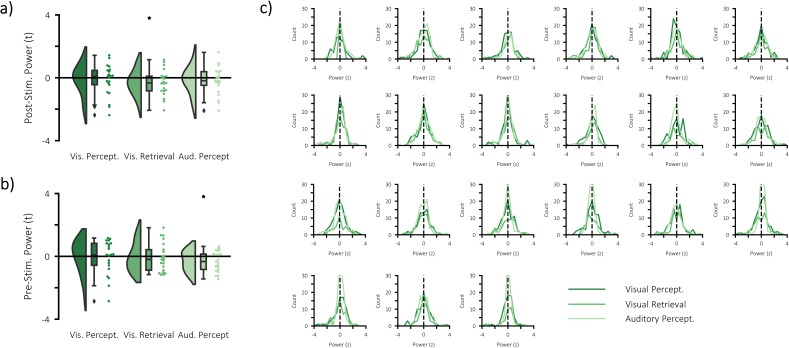
Investigating bimodal alpha power and stimulus-specific information.(a) Raincloud plot displaying the correlation between median-split post-stimulus alpha/beta power and stimulus-specific information during visual perception (each dot represents a single participant). Only during visual memory retrieval was an effect observed (p=0.045, Cohen’s dz = 0.39). Given the absence of a similar effect in the perceptual tasks, this effect may reflect an idiosyncrasy of the retrieval task such as bimodally-distributed power relating to recollection vs. familiarity. (b) Raincloud plot displaying the correlation between median-split pre-stimulus alpha/beta power and stimulus-specific information during visual perception (each dot represents a single participant). Only during auditory perception was an effect observed (p=0.037, Cohen’s dz = 0.49). (c) single participant plots of the distribution of post-stimulus alpha/beta power across trials for the three conditions. The overarching trend is a singular peak around zero, indicating a unimodal distribution.